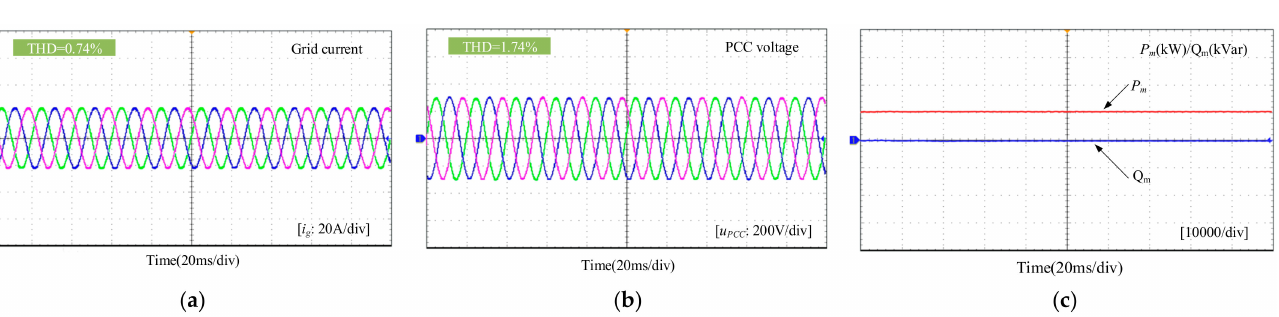
Figure 18. Experiment results with the impedance reshaping control strategy when SCL = 50%. ( a ) Grid current, ( b ) PCC voltage, ( c ) active and reactive